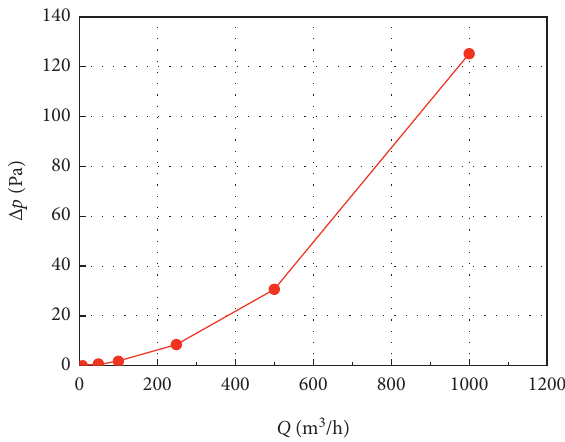
Figure 9: Pressure loss curve of nozzle flowmeter.